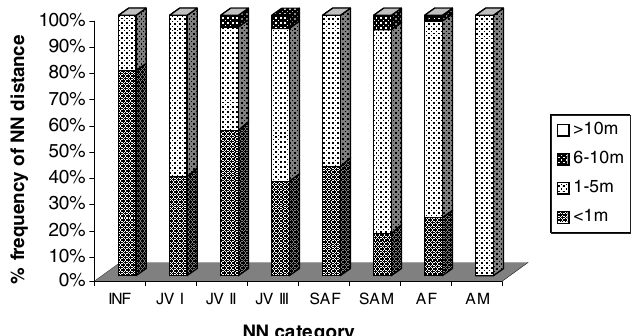
Figure 4. Percentage frequency of NND in relation to NN categories (Symbols as in